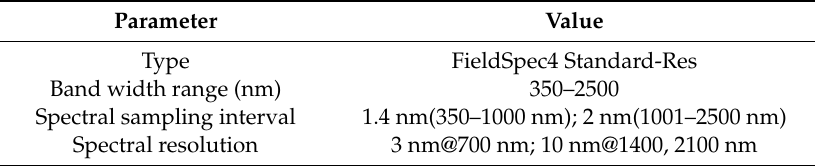
Figure 6. UAV image of the control and check surfaces. To ensure the precision of the spectroradiometer measurement, the measurement was started after 30 min of preheating. To reduce the accumulated error, the calibrated white reference was measured prior to each sample measurement. Besides, the measurement should be carried out in a steady state of illumination, the calibration white reference was measured when the illumination